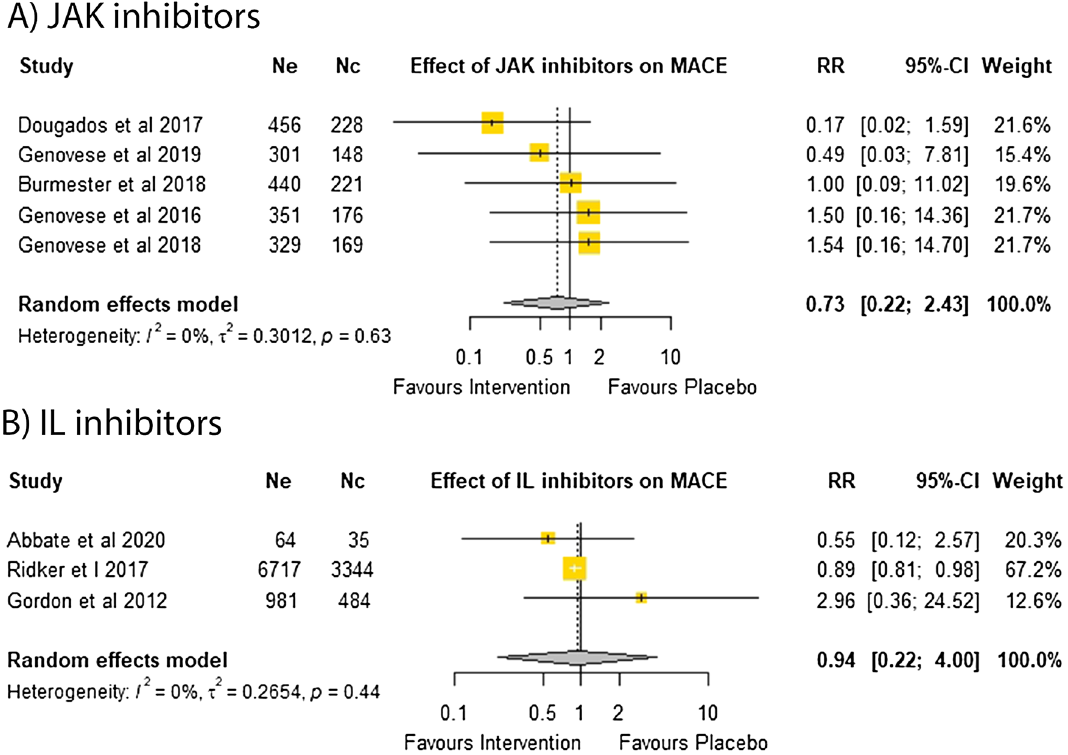
Figure 2. Effect of DMARDs on major cardiovascular events.